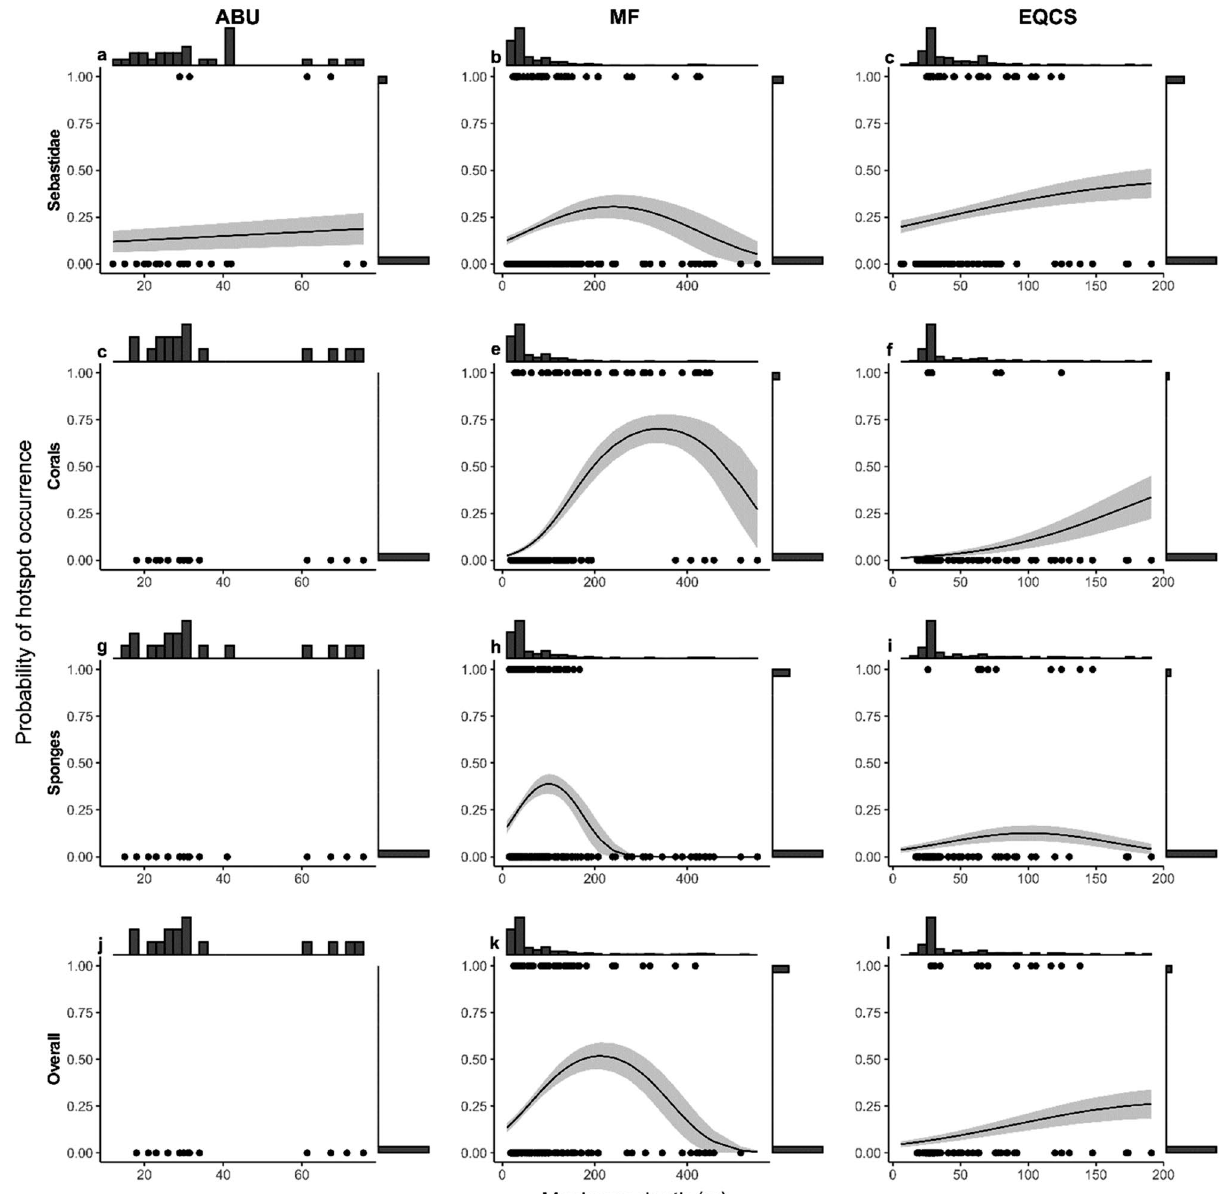
Figure 3. Probabilities of hotspot occurrence within 1-km 2 planning units for ( a – c ) Sebastidae, ( d – f ) structural corals, ( g – i ) large-bodied sponges, and ( j – l ) overall, in relation to maximum depth sampled and Upper Ocean Subregion ( ABU Aristazabal Banks Upwelling, EQCS Eastern Queen Charlotte Sound, MF Mainland Fjords). Circles are raw data (points overlap) and panel marginal histograms show their relative frequencies along each axis. Lines and shading are, respectively, logistic regression estimates with 95% confidence intervals (Table 3). Note that depth ranges differ between ocean Table 3). For instance, at a depth of 77 m, the probability of overall hotspot occurrence at Mainland Fjords was 2.4 times greater than at Eastern Queen Charlotte Sound (Fig. 3; Table 3). As detailed above, however, the deep expected depths of some Sebastidae and structural corals with high scores for conservation prioritization were sampled only at Mainland Fjords. Of 102 1-km 2 planning units containing overall hotspots, 33 included independent hotspots for more than one taxonomic group: 6 for Sebastidae and structural corals, 7 for large-bodied sponges and structural corals, 18 for Sebastidae and large-bodied sponges, and 2 for all three taxonomic groups. Similarly, of 52 16-km 2 plan- ning units containing overall hotspots, 30 included independent hotspots for more than one taxonomic group: 8 for Sebastidae and structural corals, 6 for large-bodied sponges and structural corals, 13 for Sebastidae and large-bodied sponges, and 3 for all taxonomic groups.